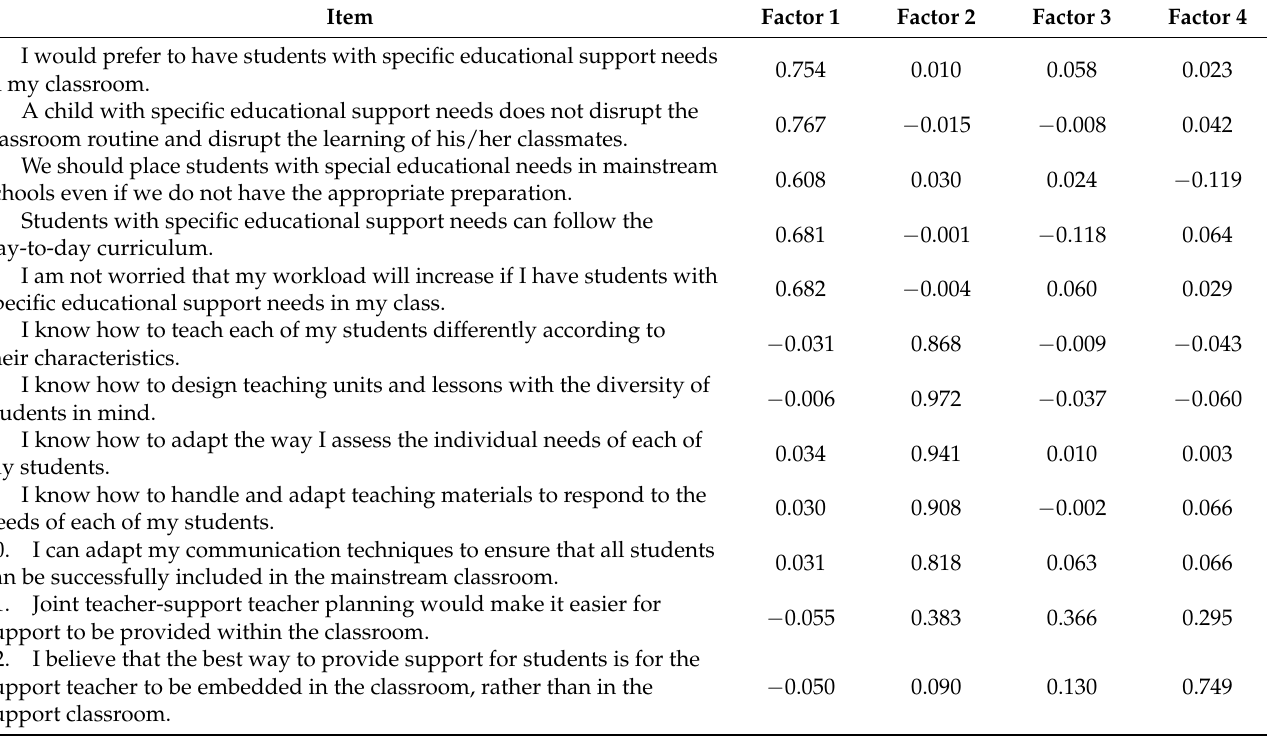
Table 2. Rotated loading matrix with Normalized Direct